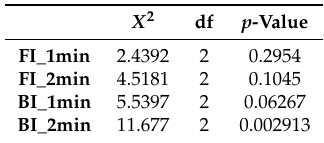
Table 15. Kruskal–Wallis rank sum test.